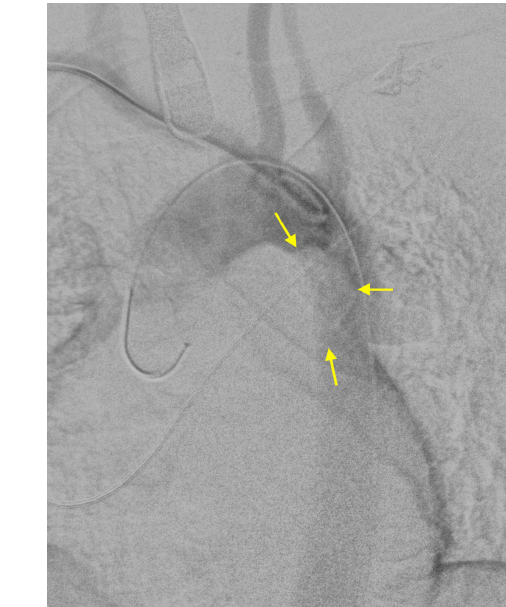
Fig. 2A - Angiogram showing the intra-aortic filling defect (yellow arrow).